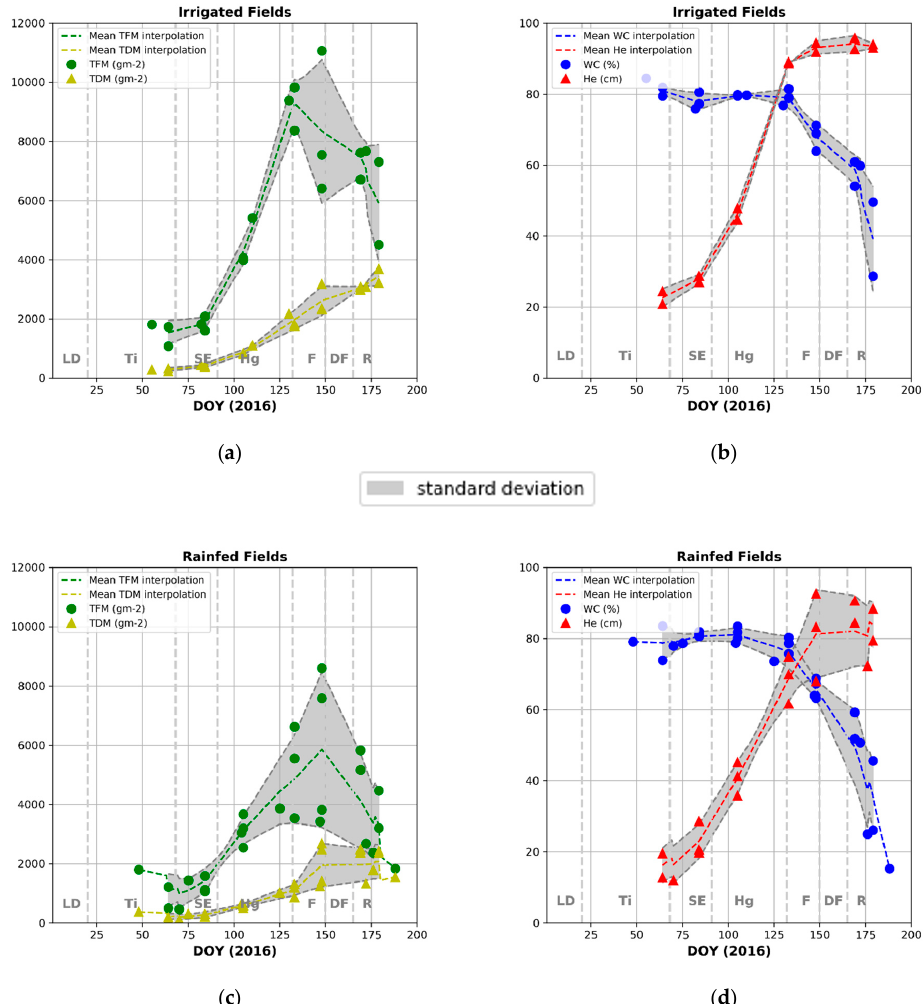
Figure 4. Temporal evolution of the wheat parameters (total fresh mass (TFM), total dry mass (TDM), plant heights (He), and water content (WC)) for irrigated fields ( a ), ( b ) and Rainfed fields ( c ), ( d ).